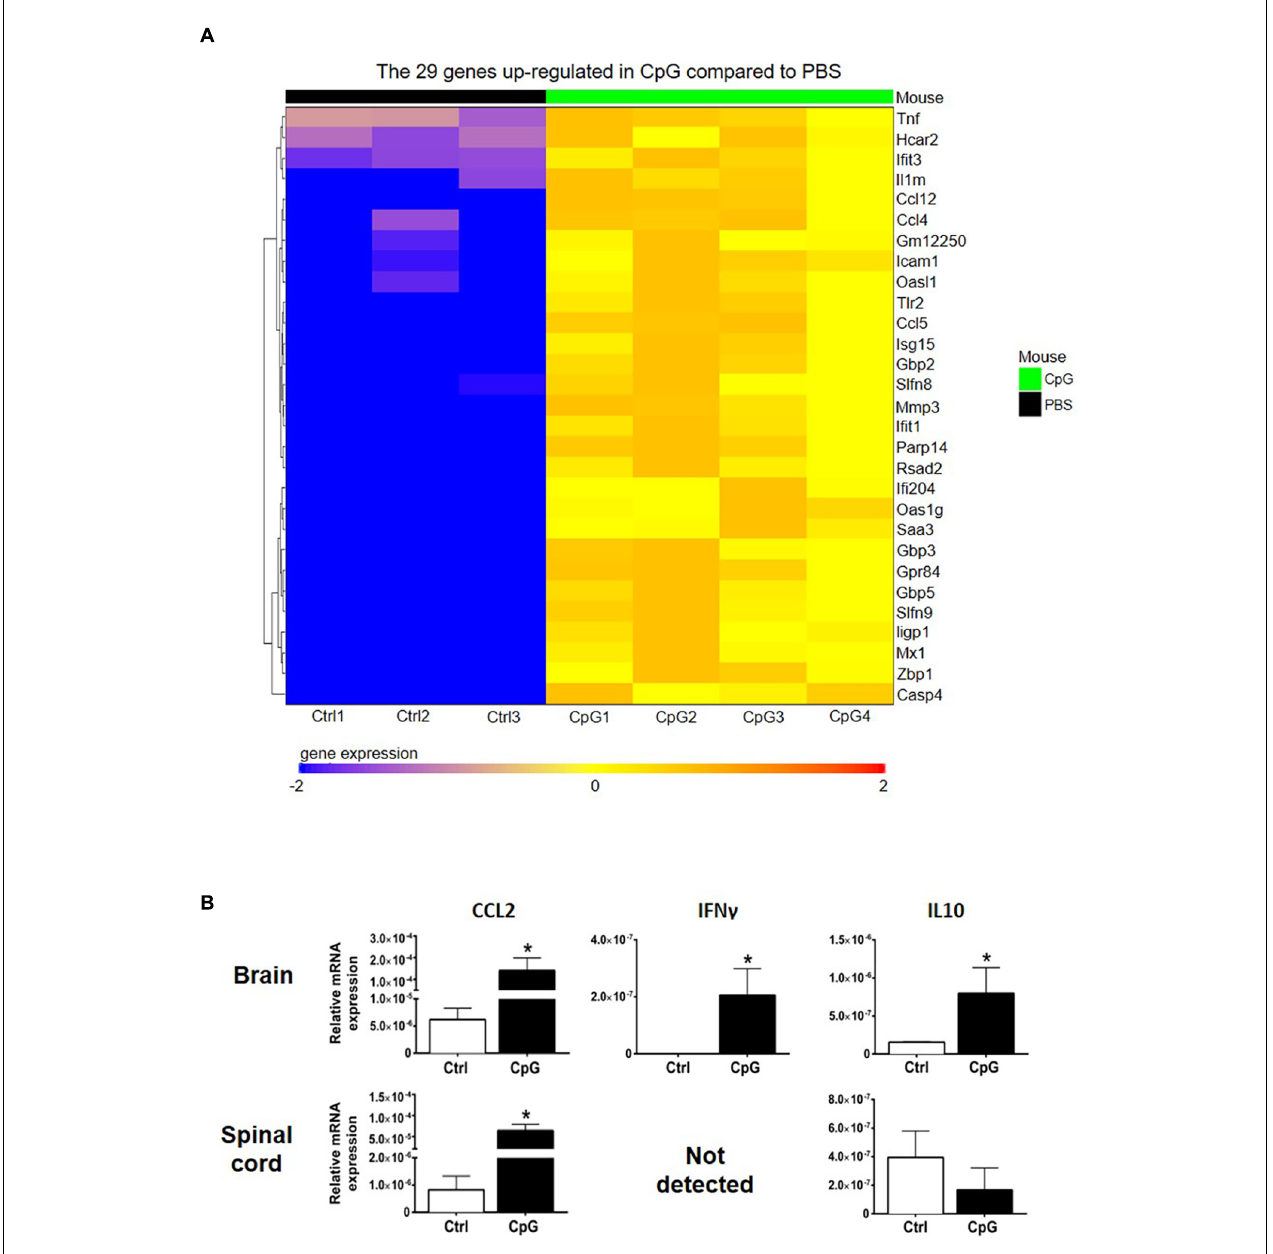
FIGURE 3 | Intrathecal CpG induced inflammation-associated cytokines and chemokines. To investigate how intrathecal CpG influences CNS inflammatory programs in healthy mice, expression of inflammation-associated mediators was analyzed by RNAseq and RT-pPCR. (A) Heatmap of RNAseq analysis of CpG-induced CNS. Intrathecal CpG induced significant upregulation of 29 genes in the brain (LogFC ≥ 2 and adjusted p -value ≤ 0.05). These genes include type I IFN response genes as well as chemokines. (B) Bar graphs show levels of CCL2, IFN γ , and IL10 mRNA in brains and spinal cords 4 h post injection ( n = 3–5 per group). Results were analyzed using the two-tailed Mann–Whitney U -test. Data are presented as means ± SD. * p <